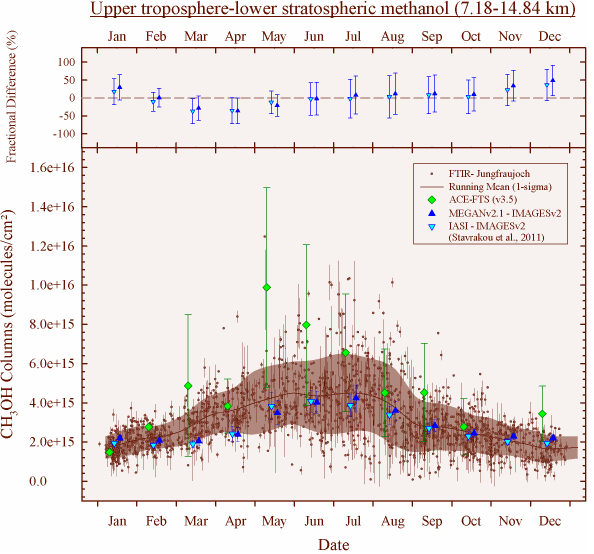
Figure 7. Upper troposphere–lower stratospheric methanol (7.18–14.84km). Dots with vertical lines representing daily mean lower-tropospheric columns over a 1-year time base and their asso- ciated standard deviation. The brown curve corresponds to a run- ning mean fit to all data points, with a 15-day step and a 2-month wide integration time. The area corresponds to the 1 σ standard de- viation associated to the running mean curve. Up and down blue triangles are the monthly means of the model IMAGESv2 simula- tions for MEGAN and IASI respectively (Stavrakou et al., 2011). Green diamonds are the monthly means of methanol retrieved from ACE-FTS occultations with the error bars representing the standard deviation (2 σ ). Upper frame show monthly fractional difference be- tween FTIR results and IMAGESv2 simulations and ACE-FTS re-